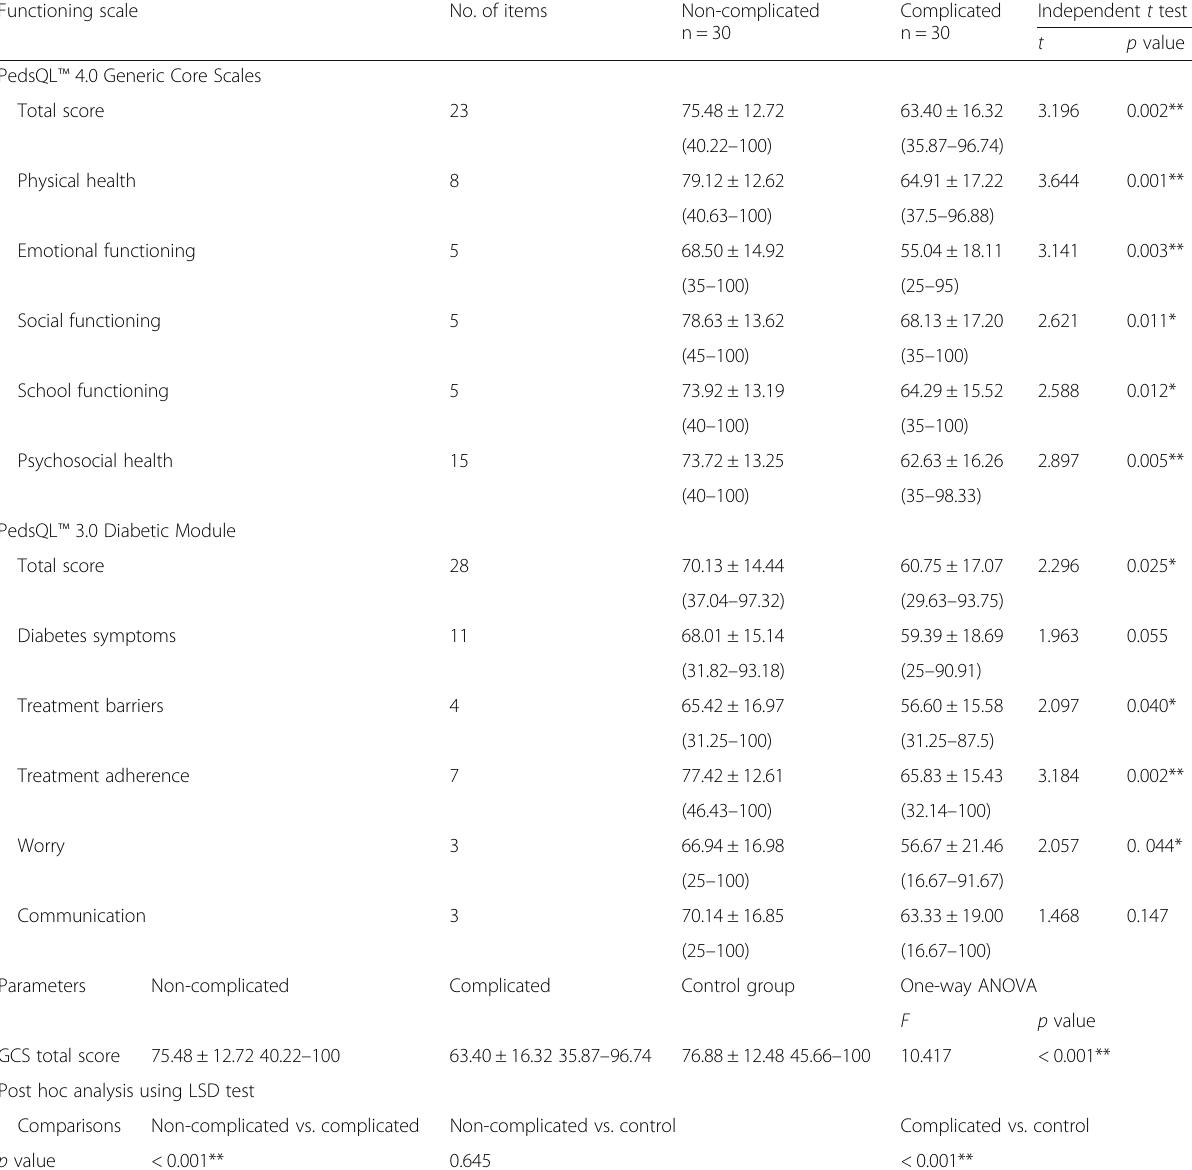
Table 5 Comparison between complicated and non-complicated groups concerning their PedsQL ™ 4.0 Generic Core Scales (GCS) and PedsQL ™ 3.0 Diabetic Module